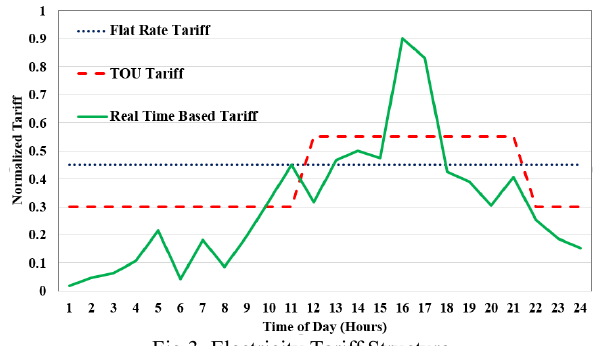
Fig.3. Electricity Tariff